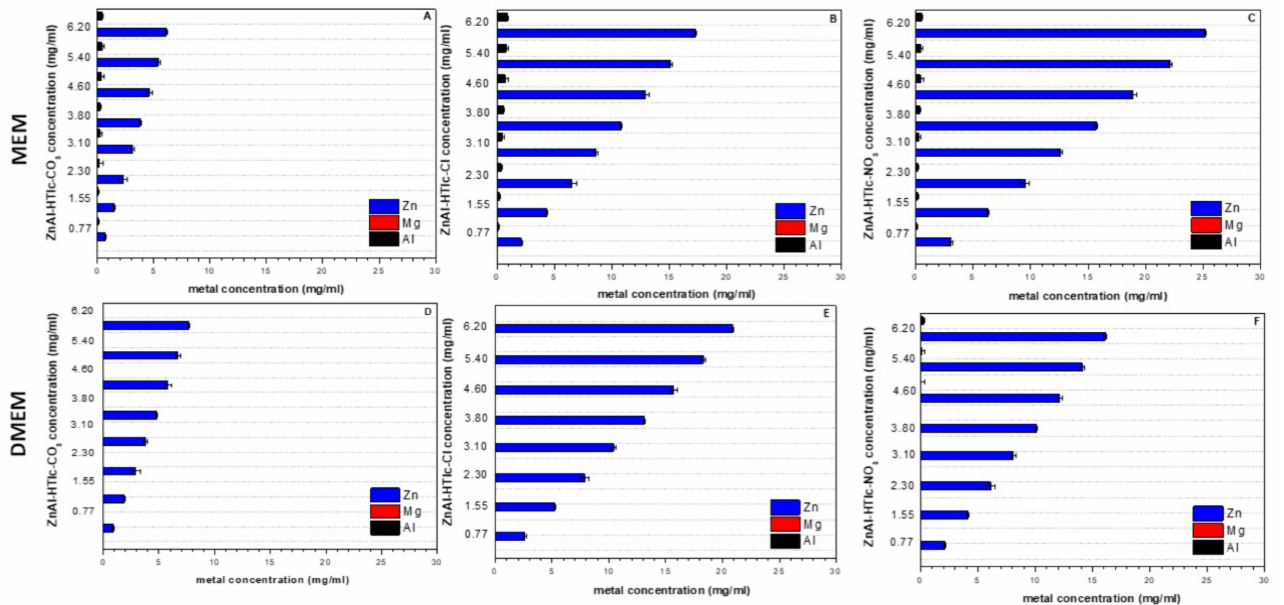
Figure 4. Concentrations of Al 3+ , Mg 2+, and Zn 2+ more exceeding that found in the controls: MEM and DMEM. Supernatants of: ( A ) ZnAl-HTlc-CO 3 in MEM; ( B ) ZnAl-HTlc-Cl in MEM; ( C ) ZnAl- HTlc-NO 3 in MEM; ( D ) ZnAl-HTlc-CO 3 in DMEM; ( E ) ZnAl-HTlc-Cl in DMEM; ( F ) ZnAl-HTlc-NO 3 in